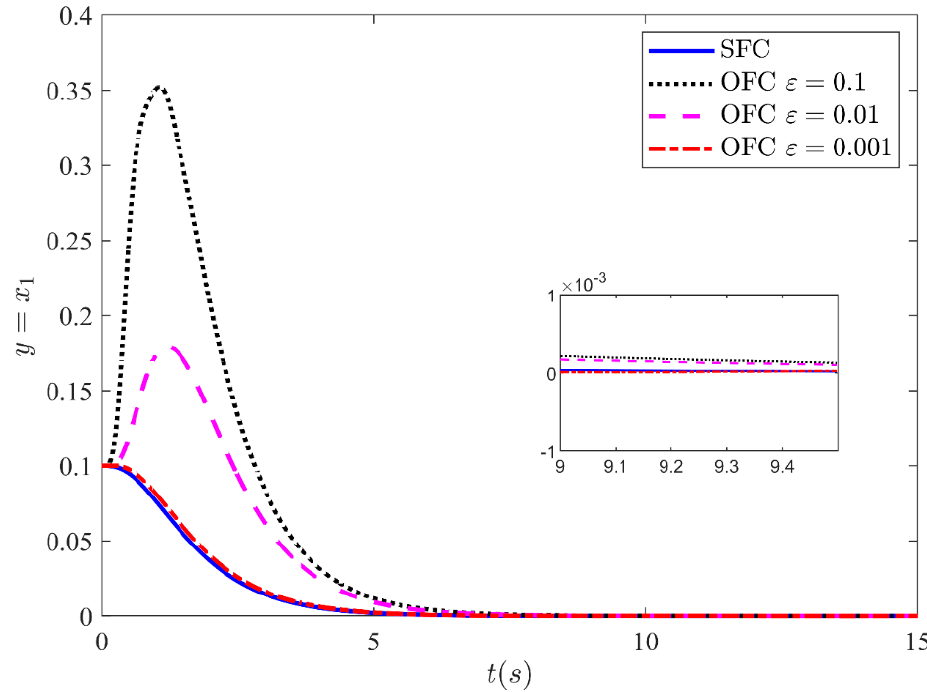
Figure 9. Stabilizing performance of the CL system under SFC and of OFC with SMC based HGO with input saturation for three different values of ε = 0.1, ε = 0.01, and ε = 0.001.